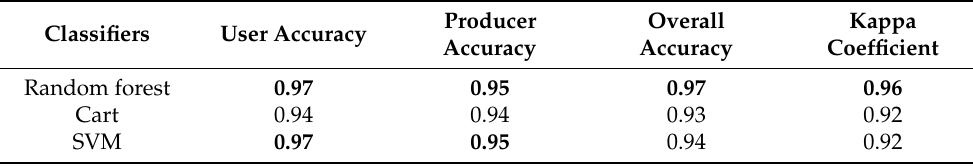
Table 6. The accuracy evaluation indicators of different